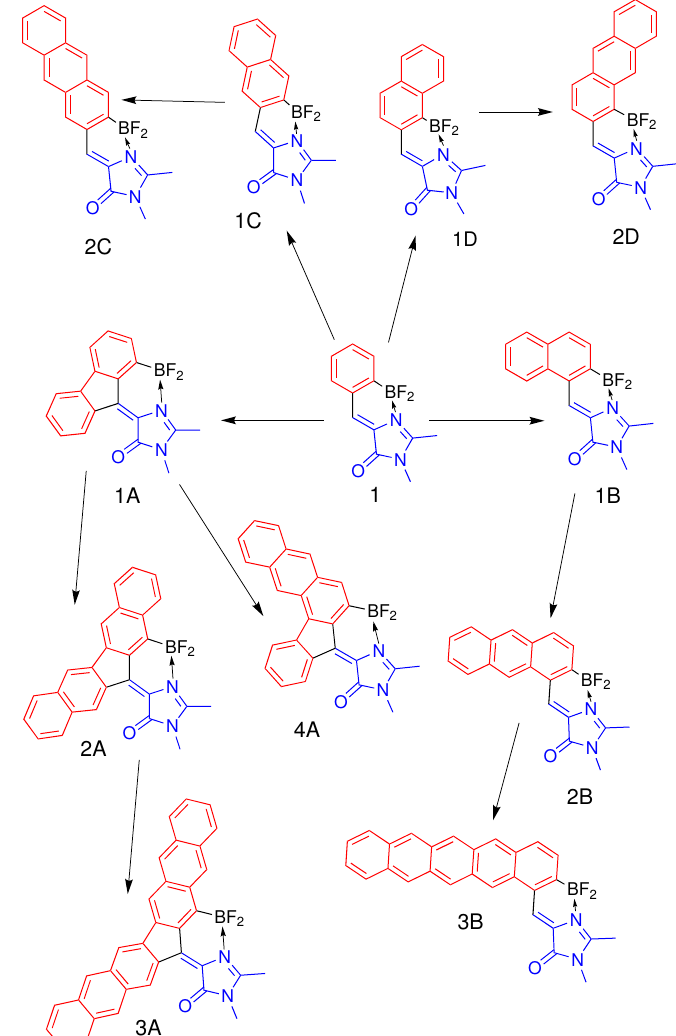
Figure 1. Four structural classes of the annulated locked GFP chromophores: A , B , C , and D . Fluorene- based compound 1A has been synthesized and characterized in this work, while compounds 1 and 1B have been synthesized and characterized previously [14,15].The GFP chromophore’s core (subsystem I), which includes imidazolinone and the methine bridge double bond, is depicted in blue, and annulated PAHs (subsystem II) are highlighted in